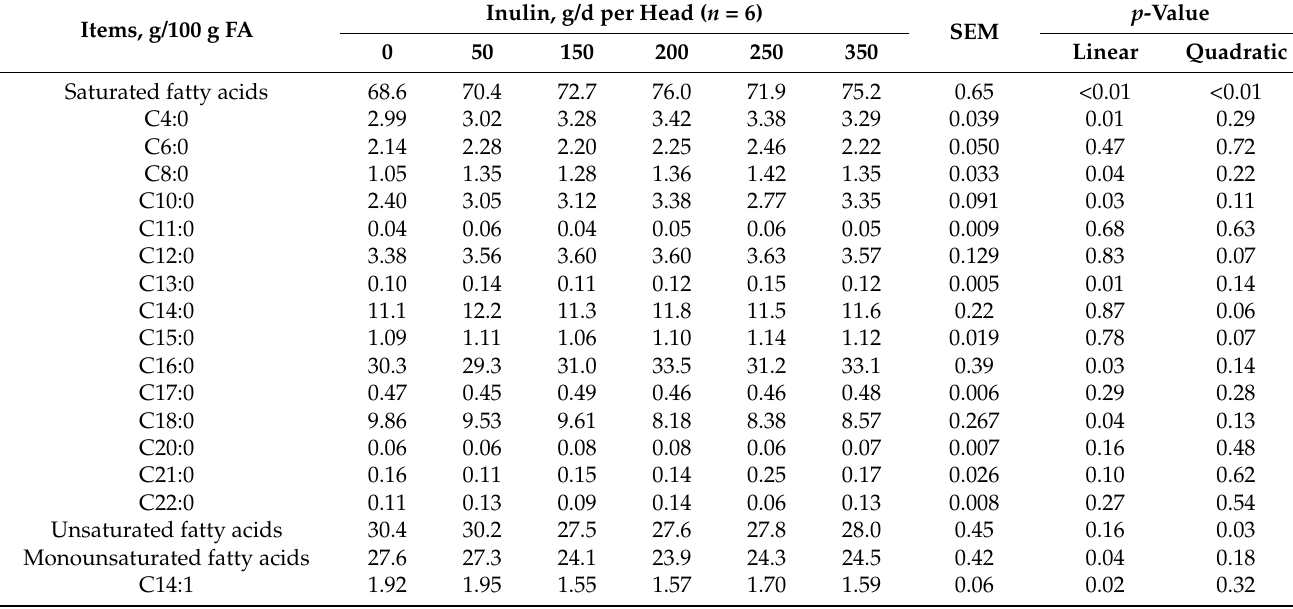
Table 4. Effects of inulin on milk fatty acids in dairy